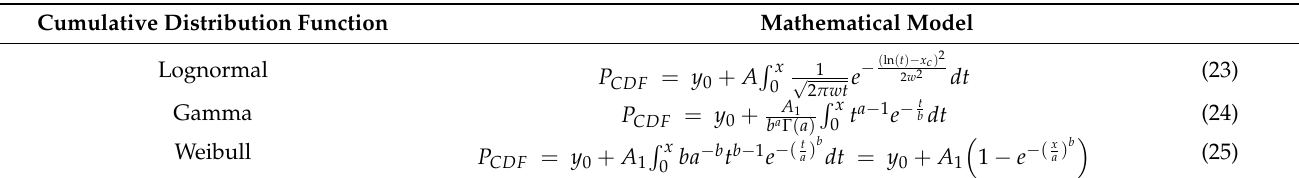
Table 2. Cumulated probability distributions used in the analysis.